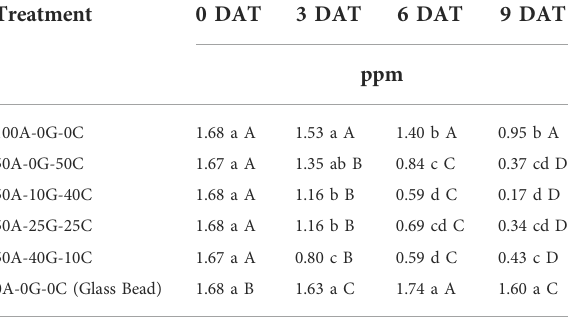
TABLE 3 Effect of treatment group on orthophosphate concentration at eutrophic solution at 0, 3, 6, and 9 days after treatment (DAT). Treatment 0